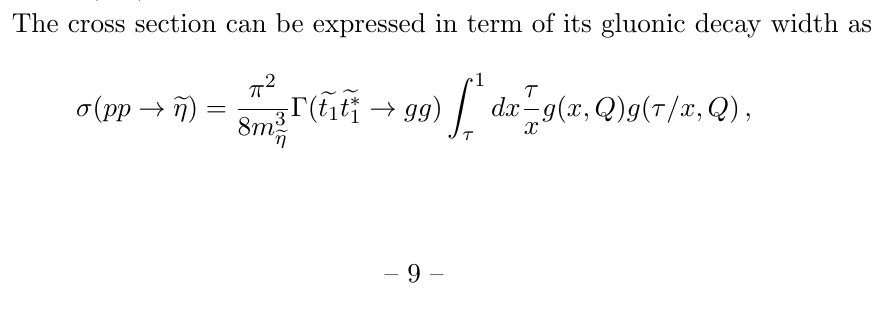
Figure 4 . In this extreme case of m A ! 1 the contribution to eEDM vanishes. Here we show the branching ratios of the stoponium for m m = 1 TeV in the upper-left, upper-right, and lower-left panels, while m e t 2 right panel. The Im[ (cid:22) (cid:3) e (cid:0) i(cid:14) u ] = 100 ; 200, 5000, and 5000 GeV, respectively. The other parameters are the same as in (cid:12)gure